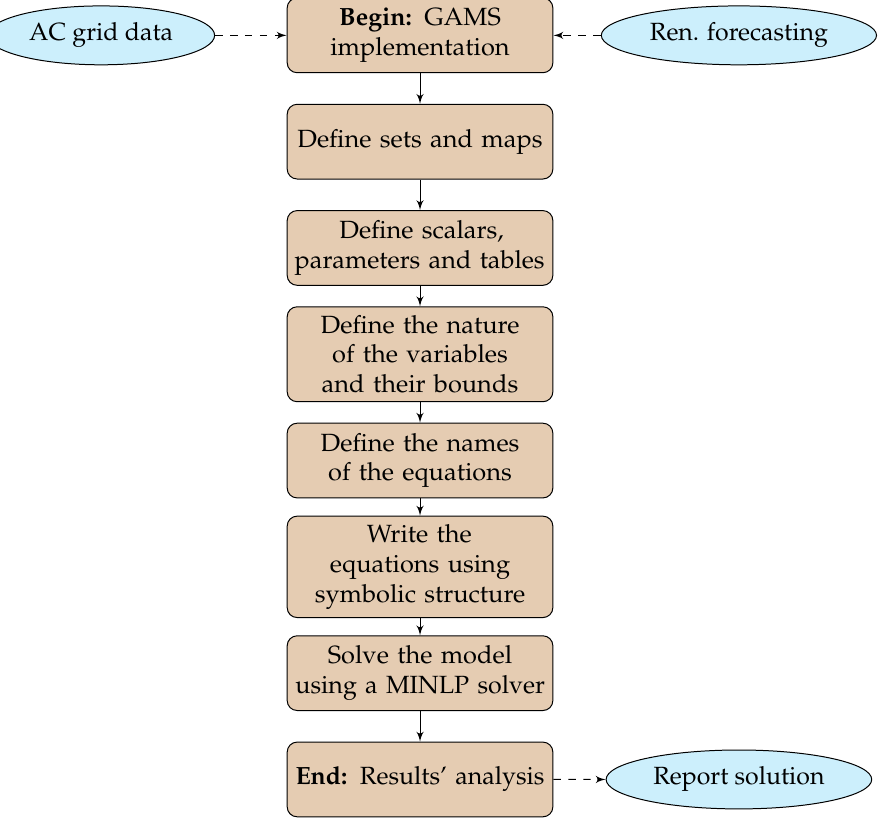
Figure 1. Flow chart of the proposed optimization approach for optimal selection and location of batteries in alternating current (AC) rural distribution